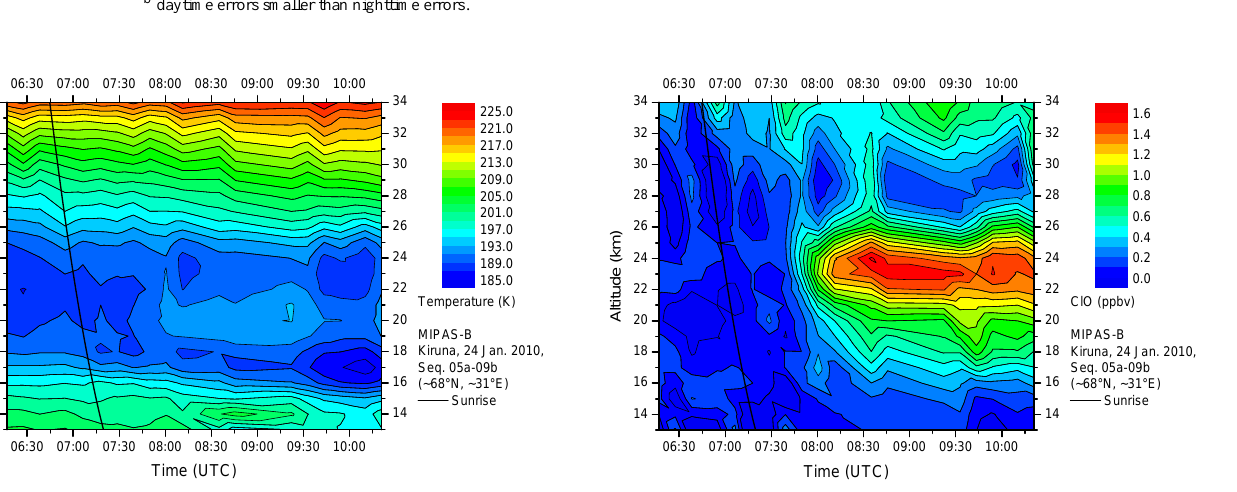
Fig. 4. Temporal evolution of chlorine monoxide (ClO) as observed by MIPAS-B on 24 January 2010 above northern Scandinavia. A broad ClO layer with a pronounced ClO maximum of more than 1.6 ppbv is visible. The strong photochemically induced increase in ClO mixing ratios starts about 45 minutes after sunrise due to the occurrence of stratospheric clouds. For details, see text.